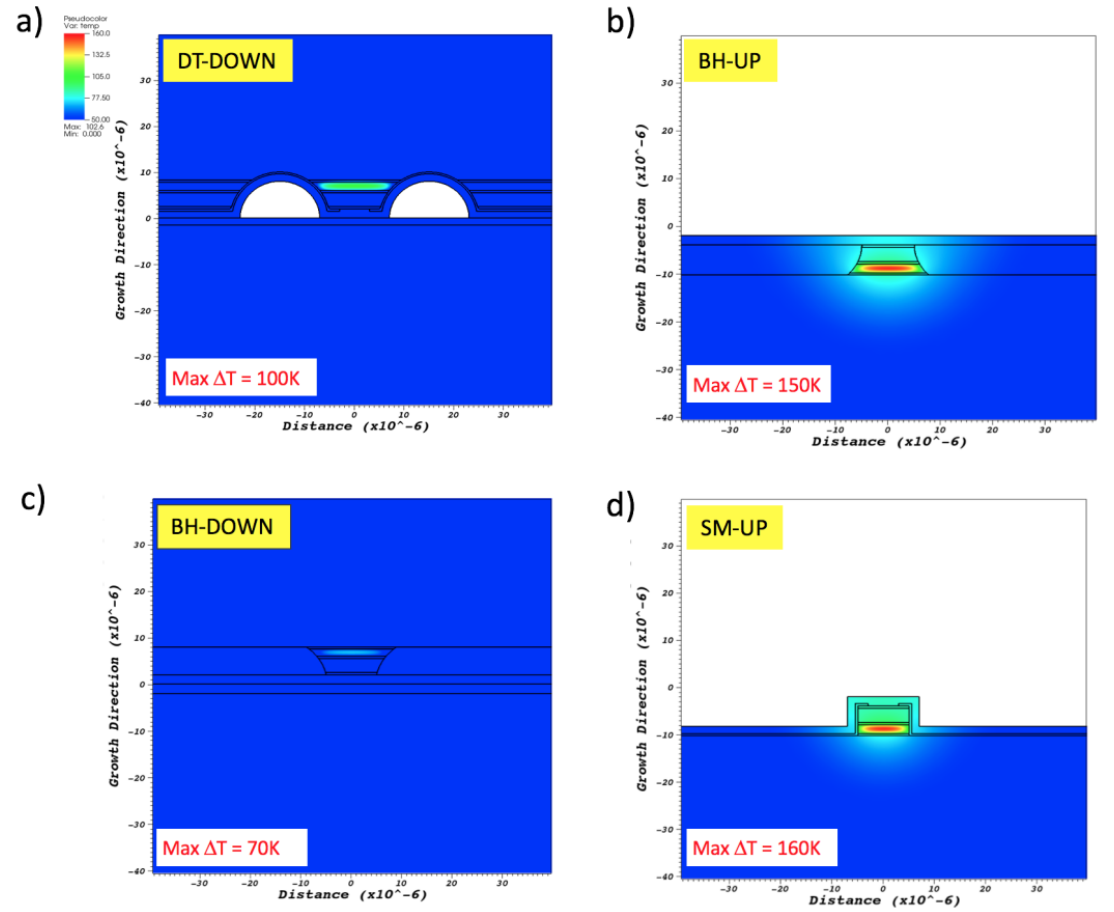
Figure 11. Comparison of calculated temperature distribution maps for AlInAs/InGaAs/InP QCLs: ( a ) epi-layer down mounted DT; ( b ) epi-layer up mounted BH; ( c ) epi-layer down mounted BH; and, ( d ) epi-layer up mounted SM; calculated for constant current density J = 4.0 kA/cm 2 (P DEN ~2.2 × 10 14 W/m 3 ).